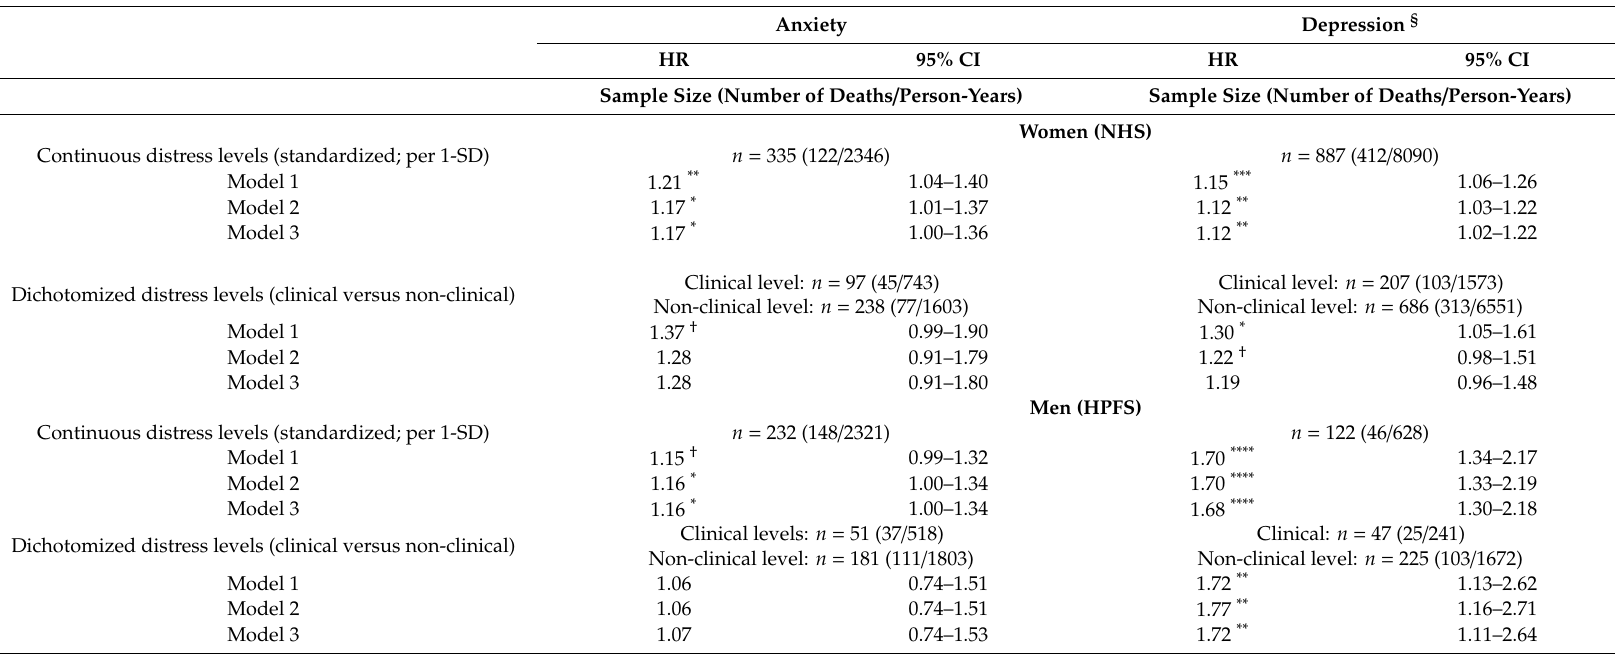
Table 4. Association of post-diagnosis anxiety and depression symptoms with mortality risk over up to 28 years of follow-up by cohort. Anxiety Depression § HR 95% CI HR 95% CI Sample Size (Number of Deaths / Person-Years) Sample Size (Number of Deaths / Person-Years) Women (NHS) Continuous distress levels (standardized; per 1-SD) n = 335 (122 / 2346) n = 887 (412 /